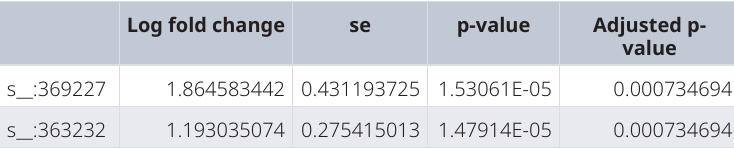
Table 1. metagenomeSeq analysis of IBD Stool 16S Pilot